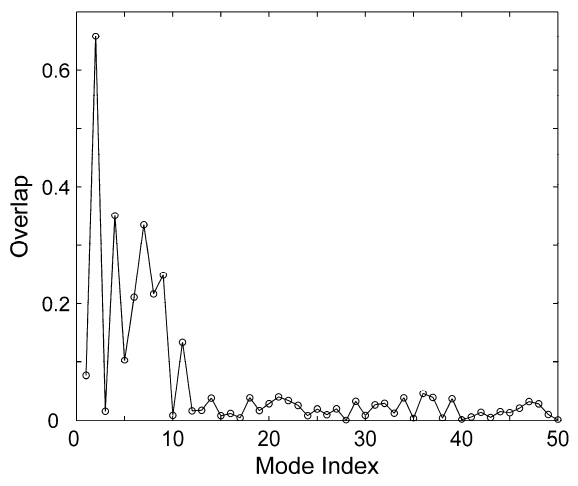
Figure 5. The overlap between the first 50 modes and the conformational change.